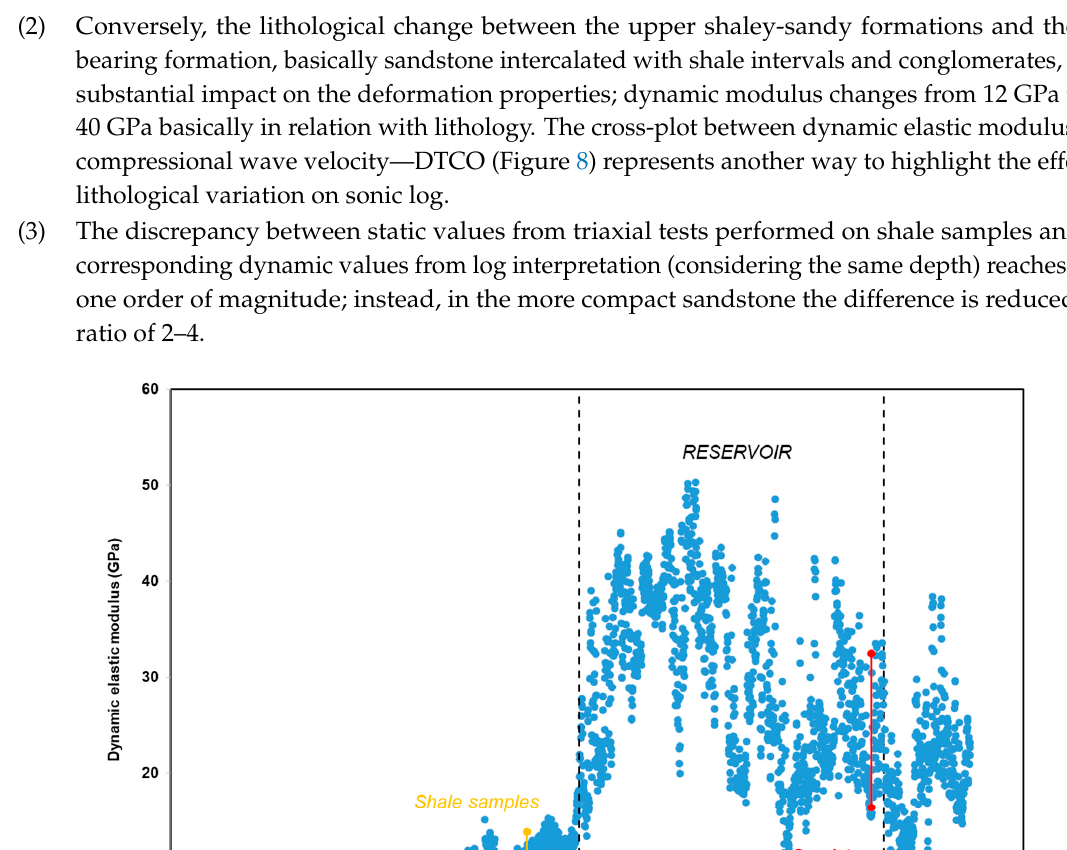
Figure 7. Well log analysis results: variation of the dynamic elastic modulus in relation to depth. Energies 2018 , 11 , x FOR PEER REVIEW